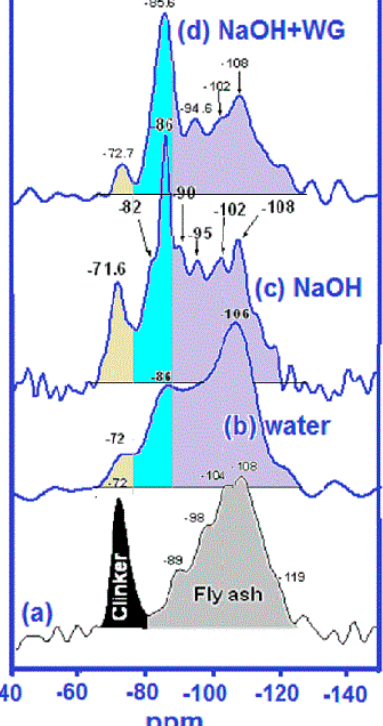
Figure 4. 29 Si MAS NMR spectra: ( a ) initial raw mix (30% clinker + 70% fly ash); ( b ) 28-day water-hydrated material; ( c ) 28-day NaOH-hydrated material; ( d ) 28-day NaOH + WG (waterglass)-hydrated material (adapted from Palomo et al. [18]).